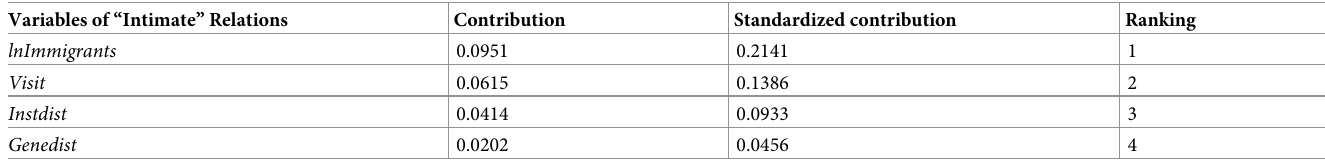
Table 9. Analysis of “intimate” variables based on dominance